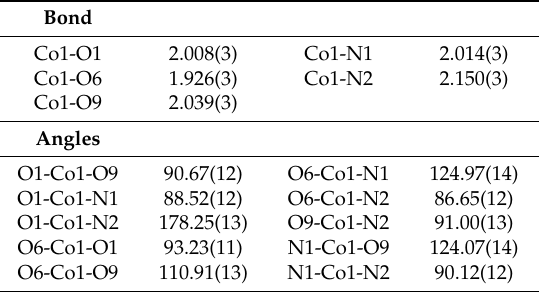
Table 6. Selected bond lengths (Å) and angles (°) for complex 2 .